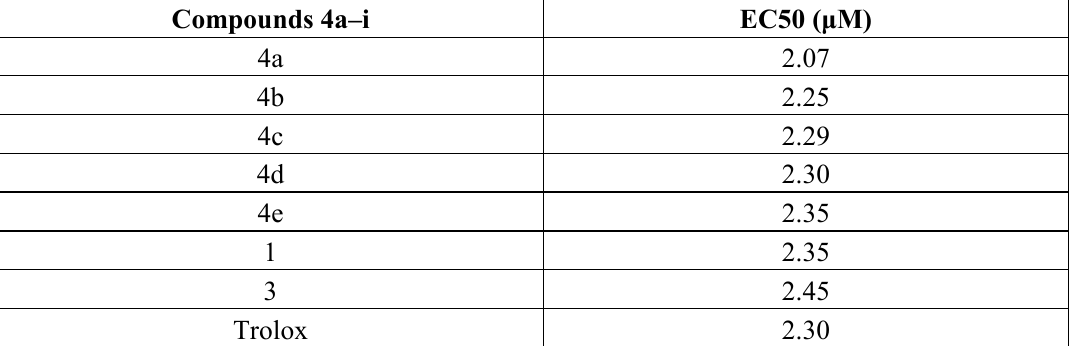
Table 1. The EC50 values exhibited by coumarinic derivatives 4